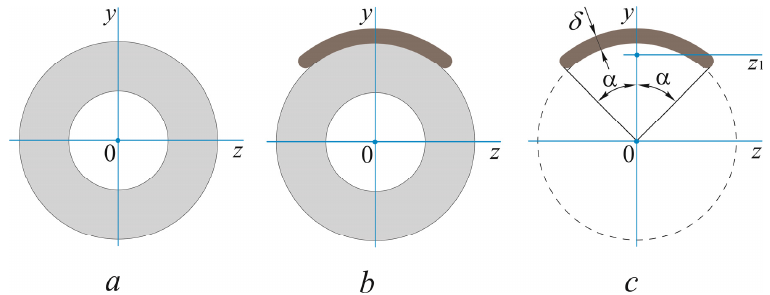
Figure 3. Cross-sections of a broken fibula model: ( a ) intact bone; ( b ) fibula—plate composition; ( c ) place of broken bone blocked with an extracortical